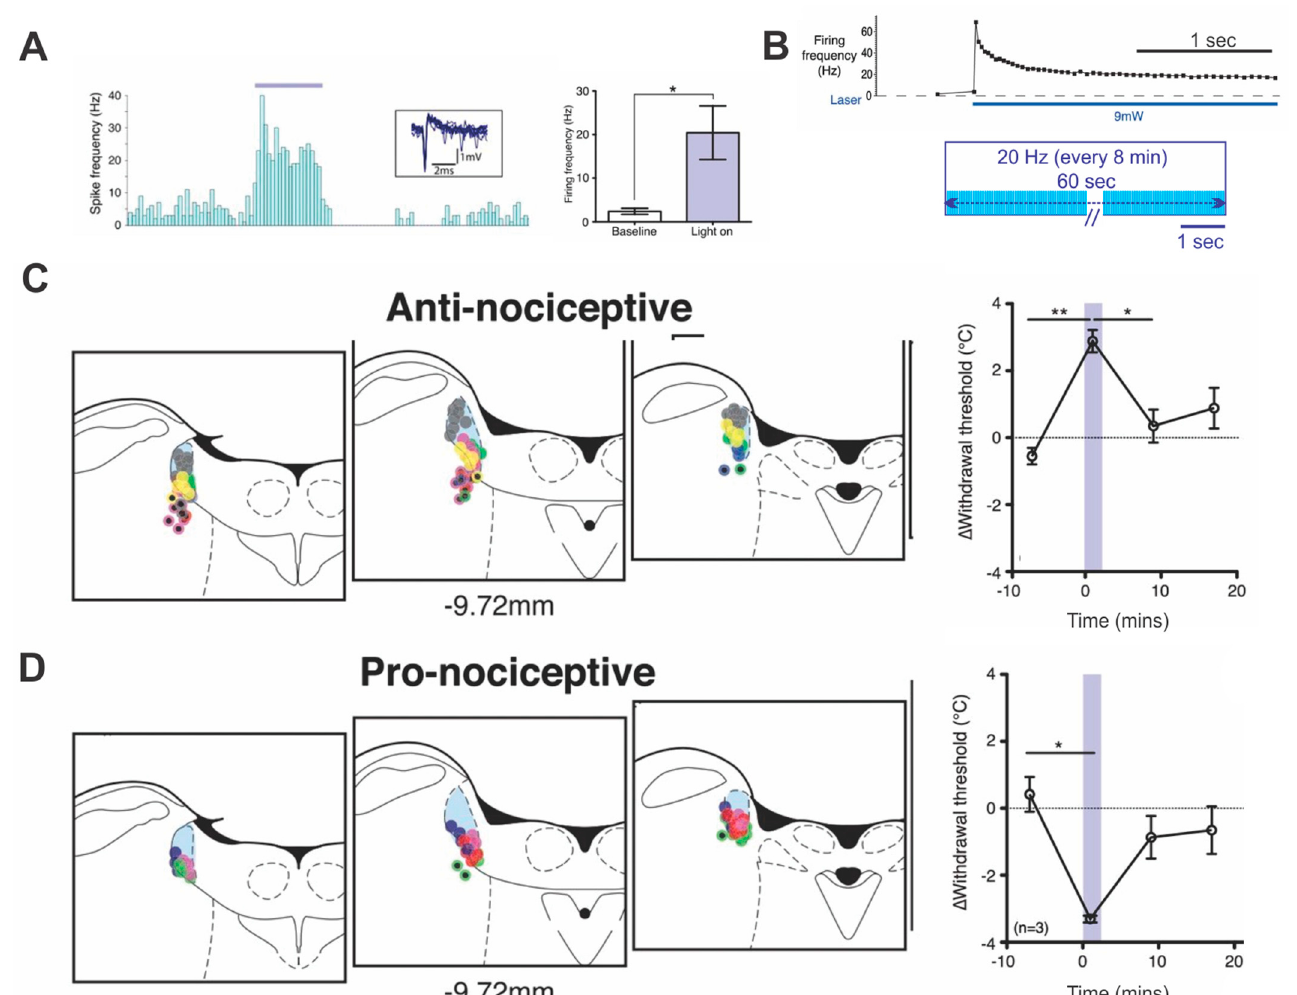
Figure 2. Regional LC optogenetic activations recruit sub-ensembles leading to differential behavior. ( A ) LC unit activity with a 20 s continuous 30 mW blue light. Note pause after activation. Mean firing rate of 20 Hz shown graphically for 5 rats. ( B ) Continuous blue light (9 mW) for 60 s was used in the nociceptive studies. Rapid adaption after initial peak resulted in maintained firing at ~20 Hz as shown in the cartoon. Long-term anti-nociception occurred with the LC light followed by a heat peak at 5 s and three repeated pairings each at an 8 min interval. ( C ) Anti-nociceptive locations identified in 7 rats with analgesic responses. Different rats are indicated by different color dots and dark core dots represent subcoerulear locations. Graph indicates increased threshold for heat pain-induced paw withdrawal at dorsal locations. ( D ) Pro-nociceptive locations in 4 rats showing increased pain sensitivity. Different rats are indicated by different color dots and dark core dots represent subcoerulear locations. Graph indicates decreased threshold for heat pain withdrawal at ventral LC sites. * p < 0.05; ** p < 0.01. Adapted with permission from [19] 2014 Creative Commons Attribution-Non-Commercial 4.0 International Public License (CC BY-NC